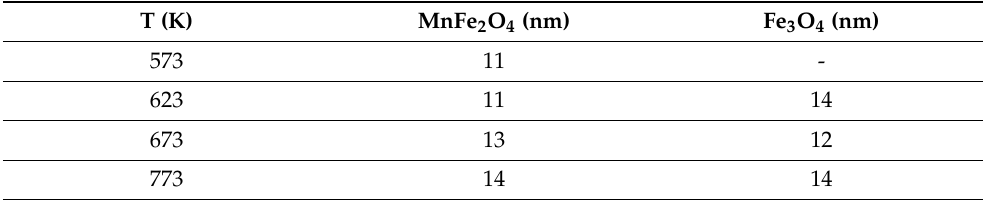
Table 1. Average crystallite sizes of the nanoparticles obtained from the XRD results.